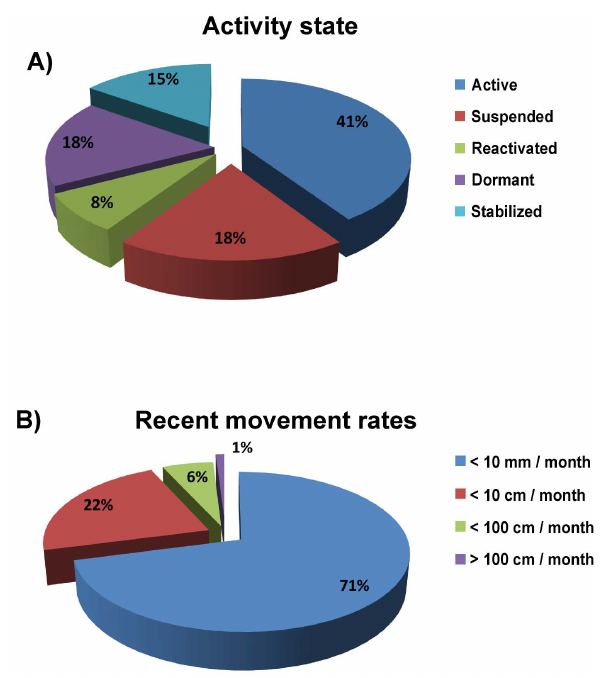
Fig. 3. Review of slope failures included in the study by (A) activity state (after WP/WLI, 1993) and (B) actual movement rates at time of response.